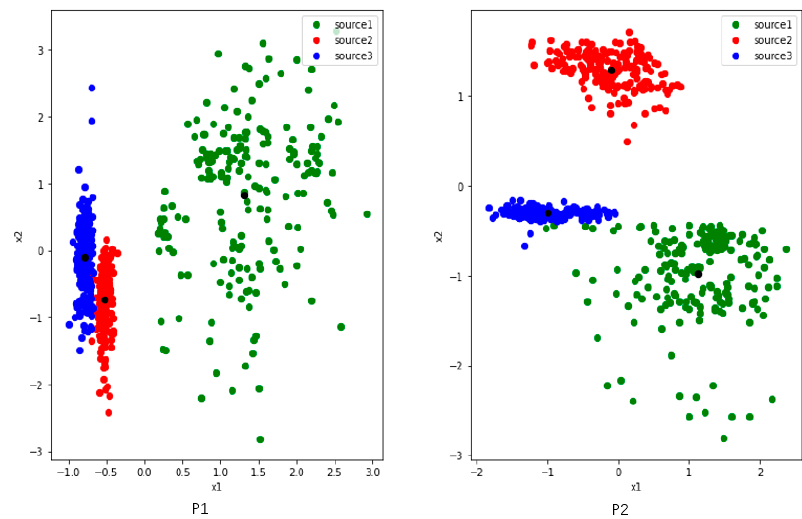
Figure 4. The distribution of three activities features which are collected from users P1 ( left ) and P2 ( right ) in UCI. The red and blue points of P1 are close to each other, while the green one is dispersed and away from them. The blue and green activities of P2 are relatively close, and the green activity is also dispersed. The black points represent the center of features belong to same class. The black points are the centers of the three classes of features.